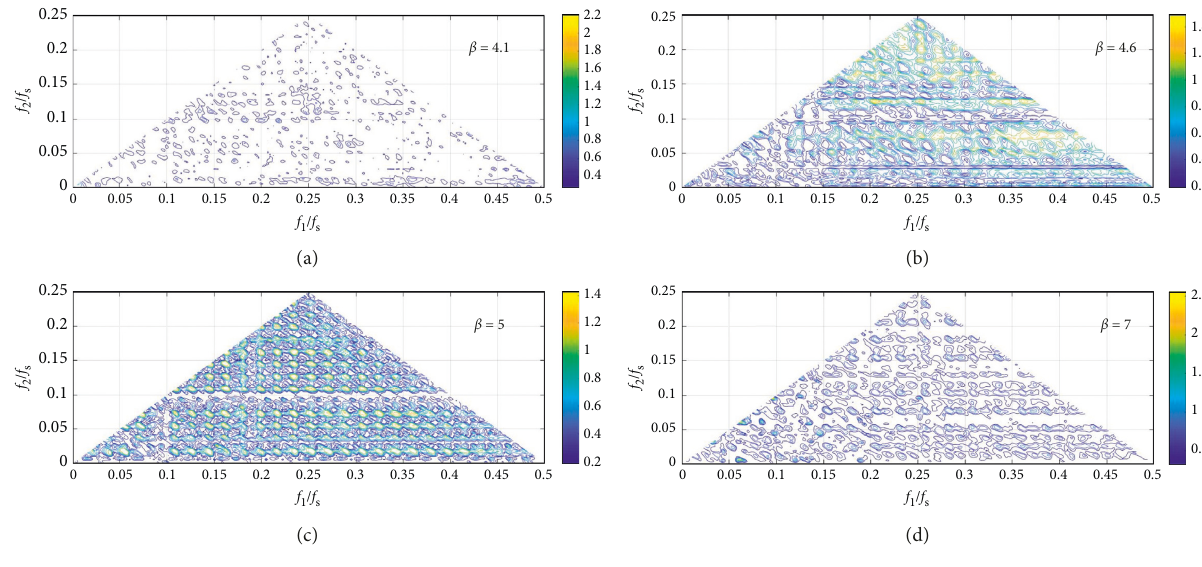
Figure 9: Bicoherence plots of the